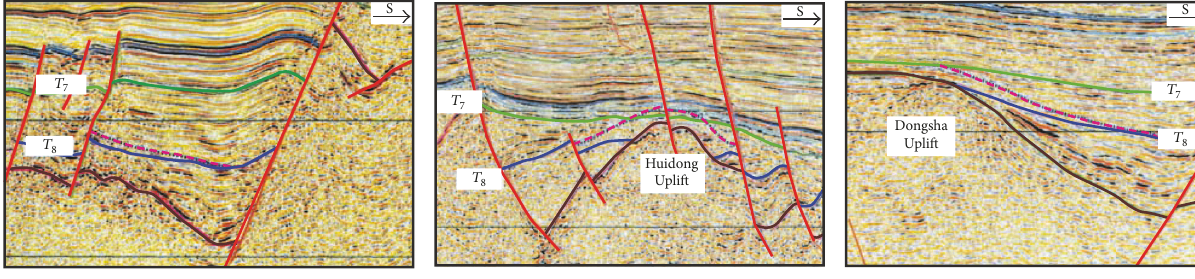
activation energy of 46 ∼ 66 kcal/mole, showing a skewed distribution of the hydrocarbon generation potential. These results of our previous papers were adopted in this